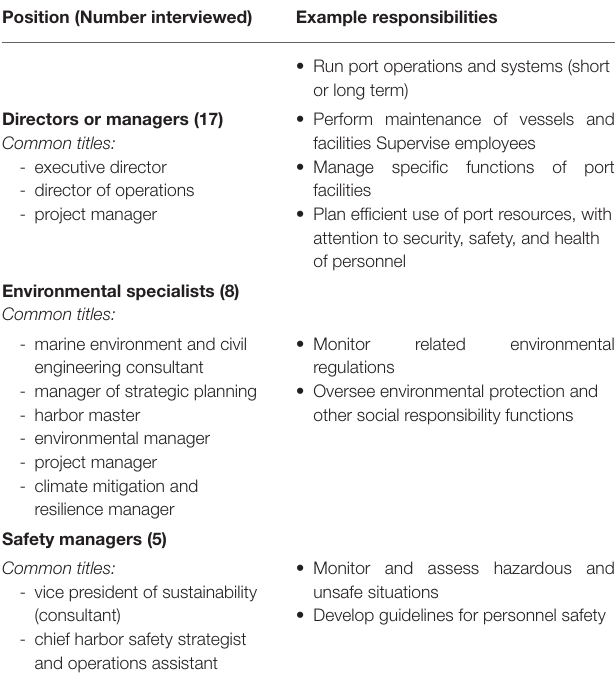
TABLE 1 | Description of responsibilities of decision maker positions and number interviewed in each category. Position (Number interviewed)